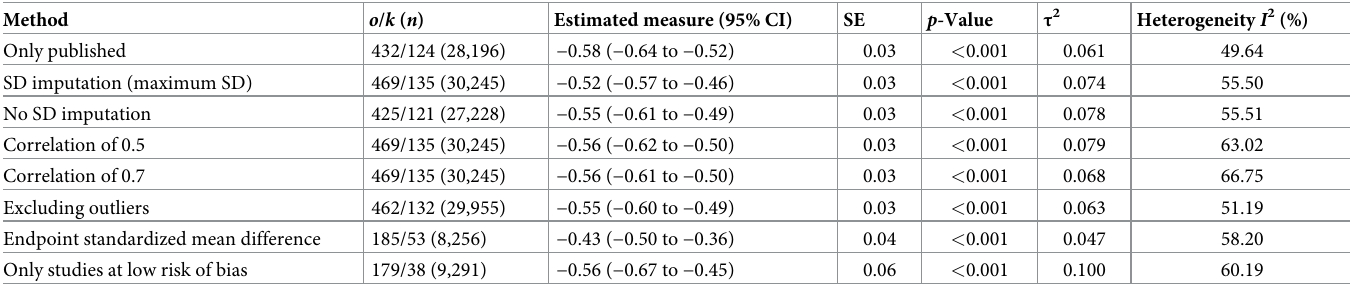
Table 5. Sensitivity analysis of each method of measure of association estimate between medication and placebo for the primary outcome (aggregate measure of mental-health-related symptoms). Method o / k ( n )